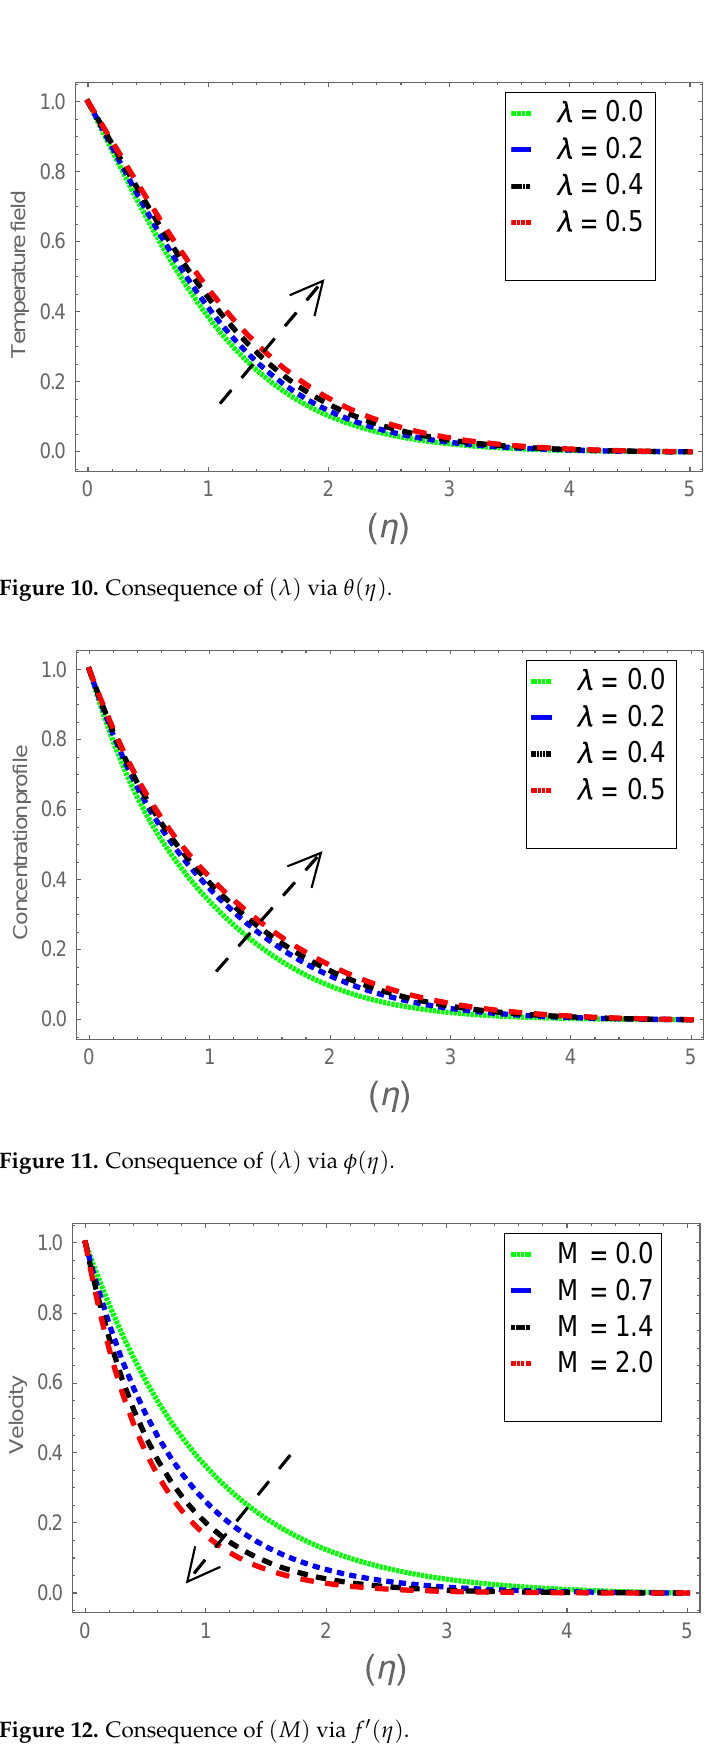
Figure 12. Consequence of